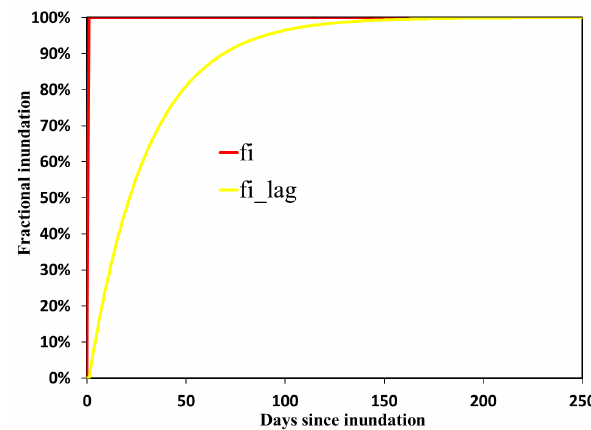
"1" Fig.2. An illustrative diagram of the impact of redox potential on inundated fraction. fi is 2" Fig. 2. An illustrative diagram of the impact of redox potential on representative of the inundated fraction that is predicted by the model. fi_lag is the inundated 3" fraction that is actively producing methane. 4" inundated fraction. fi is representative of the inundated fraction that "5" is predicted by the model. f i tively producing